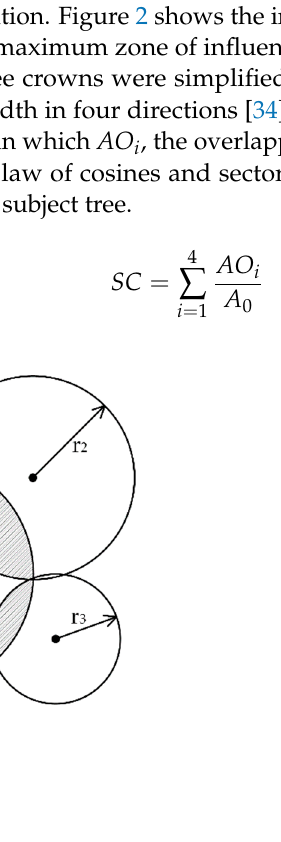
Figure 2. Overlap area of subject tree (the dark part). The crown width of subject tree was r 0 , crown widths of neighboring trees were r 1 , r 2 , r 3 , and r 4